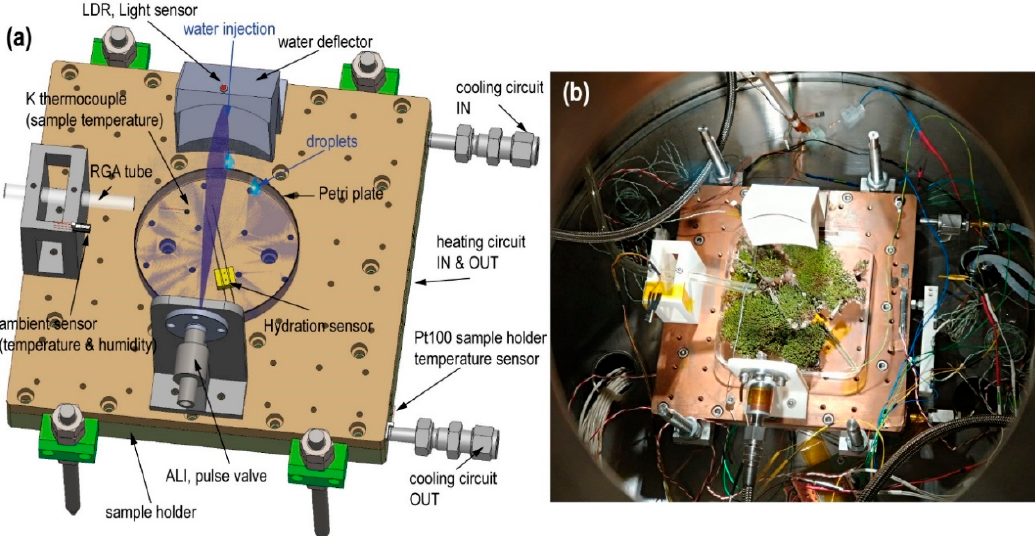
Figure 3. ( a ) Sample holder technical draw (top view) with all instrumentation for the water injection system. ( b ) Photograph (top view) of the experimental assembly with biological sample (moss).